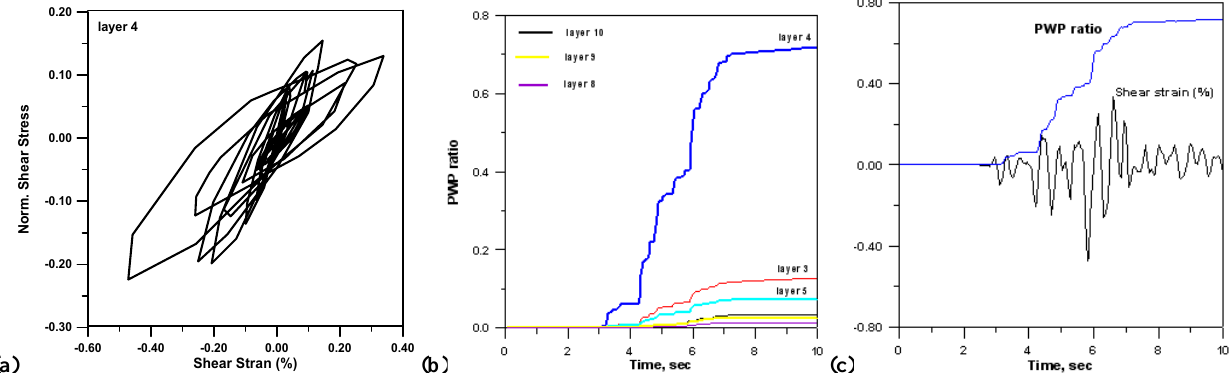
Figure 26 Fig. 26. Stress-strain history (a) for the layer with high probability to liquefy; PWP time histories at different ground level (b) ; PWP and shear strain time histories (c) for the layer with high probability to